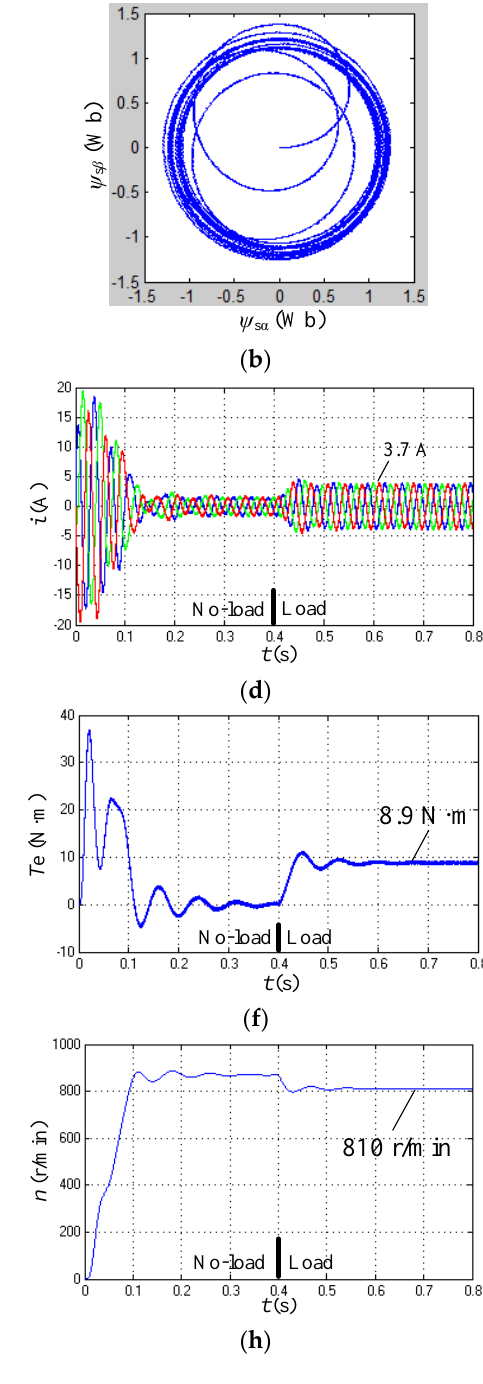
Figure 6. Simulation waveforms of flux, current, torque and speed in two methods. ( a ) Stator flux trajectory in conventional SVPWM; ( b ) Stator flux trajectory in CMRSVPWM; ( c ) Stator currents in conventional SVPWM; ( d ) Stator currents in CMRSVPWM; ( e ) Electromagnetic torque in conventional SVPWM; ( f ) Electromagnetic torque in CMRSVPWM; ( g ) Rotor speed in conventional SVPWM; ( h ) Rotor speed in CMRSVPWM.